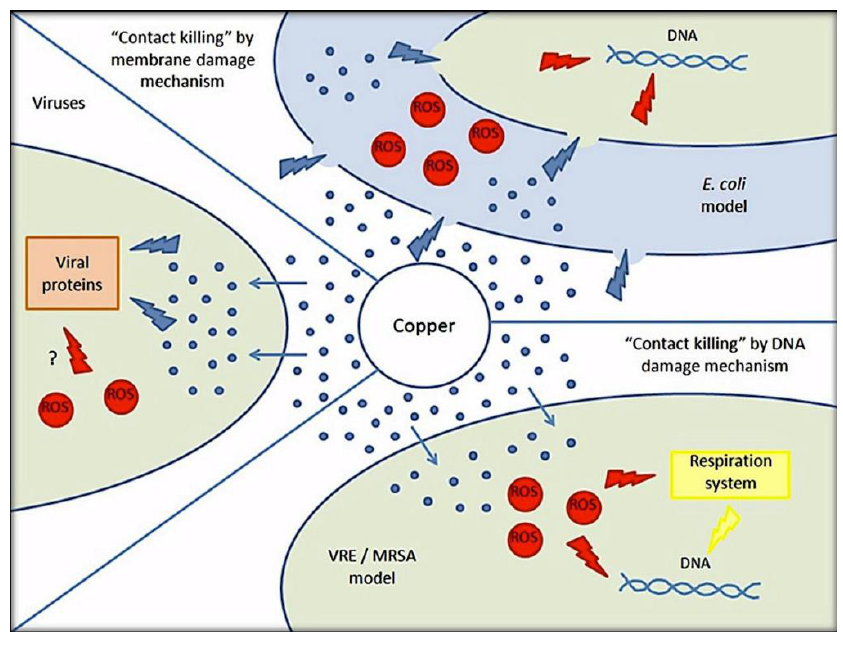
Figure 4. Possible “Contact killing” mechanisms of Cu against bacteria, fungi and viruses. Reproduced with permission from ref [63].